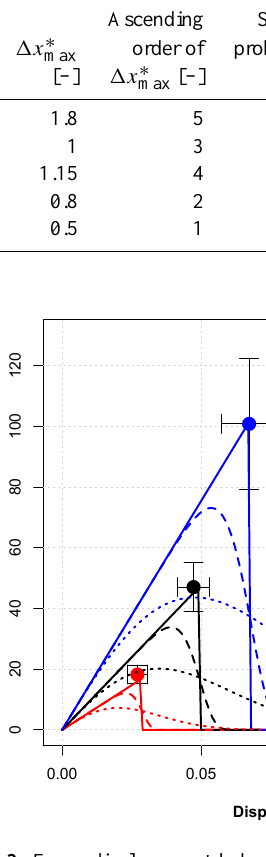
Fig. 3. Force-displacement behavior of 1 (red), 2 (black) and 3 (blue) mm diameter root classes. Points and error bars indicate mean and standard deviation measured in field pullout experi- ments (Schwarz et al., 2011). Curves show the modeled force- displacement for three values of the Weibull exponent, ω = 2 (dot- ted line), ω = 10 (dashed line), and ω = 100 (solid